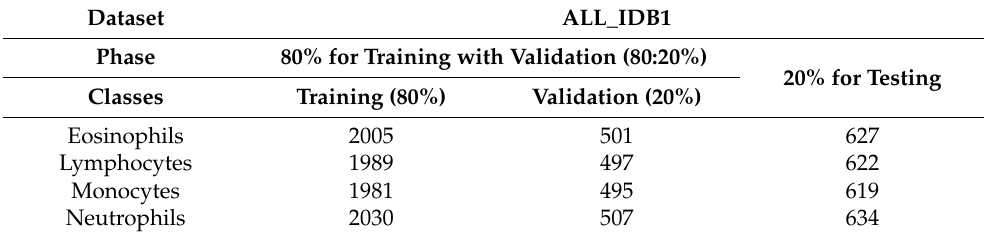
Table 1. Splitting of the WBC